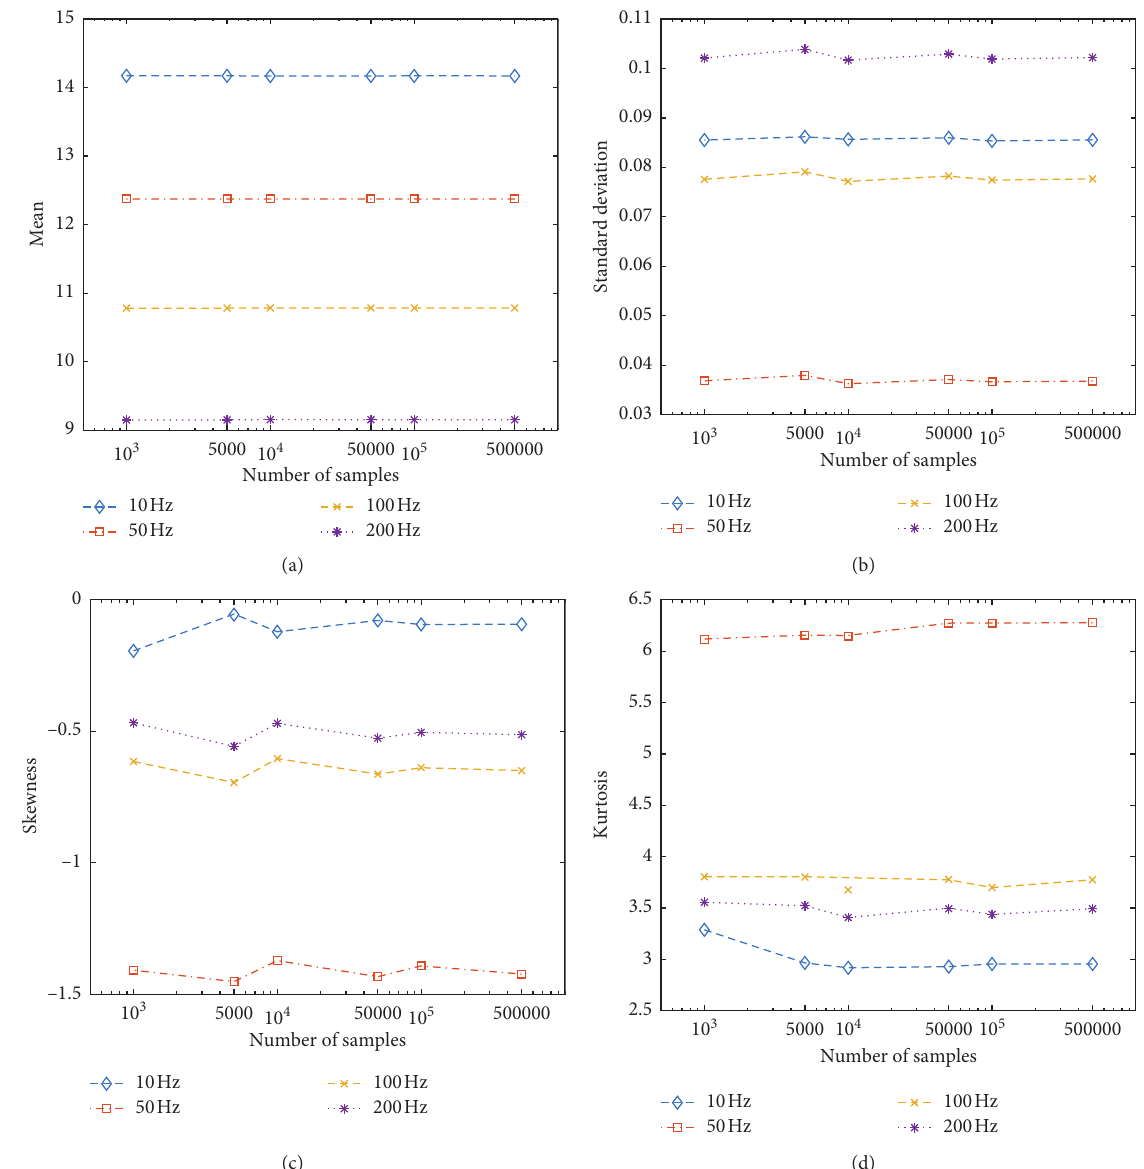
Figure 2: First four statistic moments of DSCF obtained with different numbers of samples: (a) mean; (b) standard deviation; (c) skewness; (d)